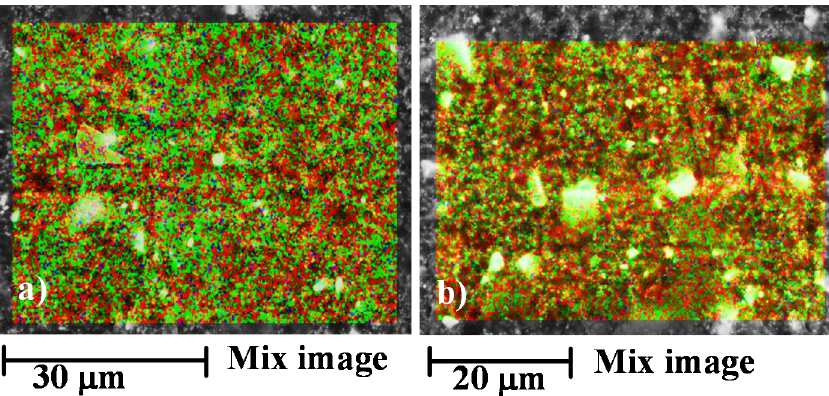
Figure 4. Energy dispersive X-ray (EDX) performed on the fracture surface of the sample 1GNPs before and after UV irradiation: ( a ) mix image of 1GNPs sample; ( b ) mix image of 1GNPs (550) sample.